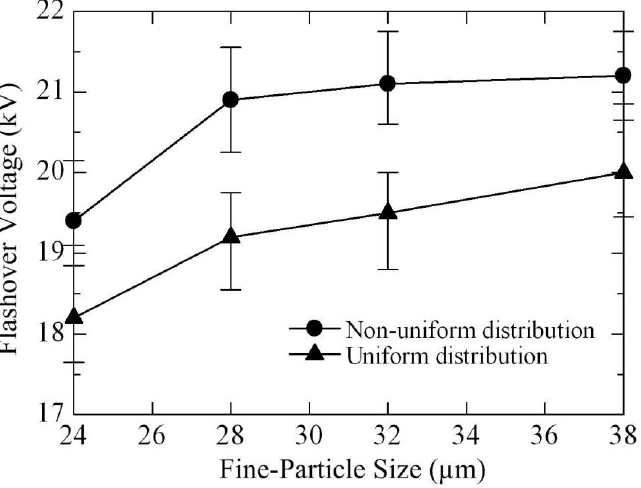
Figure 6. Relationship between flashover voltage and fine ‐ particle size with particle amount of 10 mg under different distribution conditions.